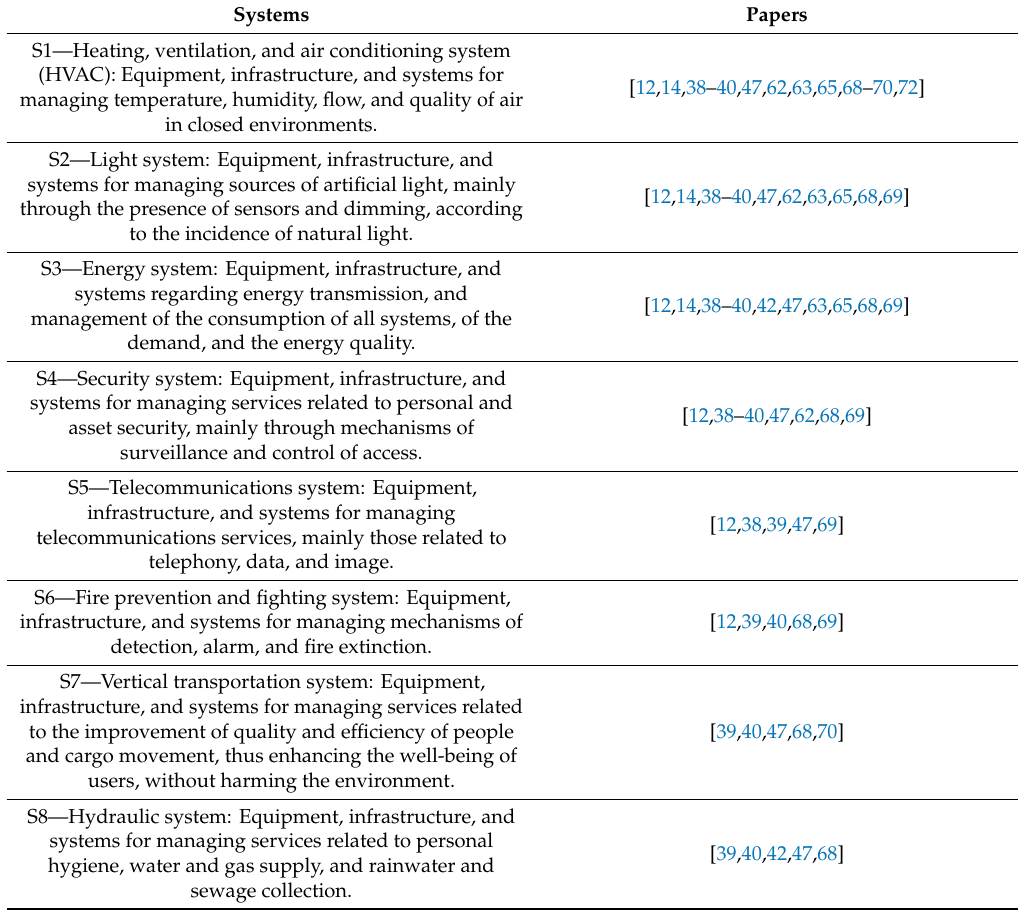
Table 2. Main systems in smart